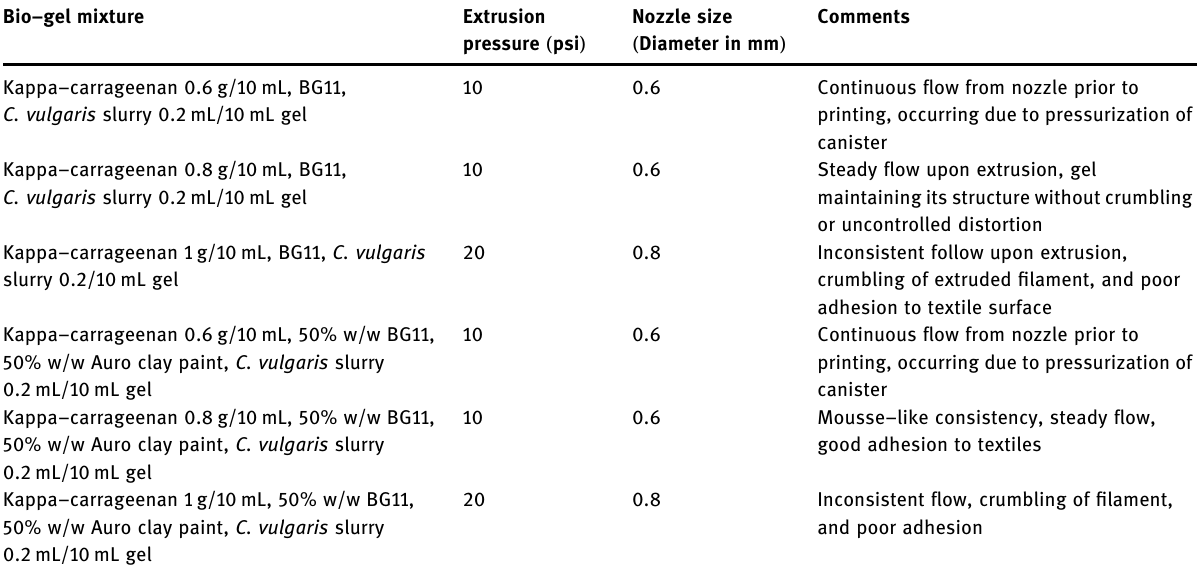
Table 6: 3D printing mixtures tested, extrusion conditions, and matrix behaviour during mechanical